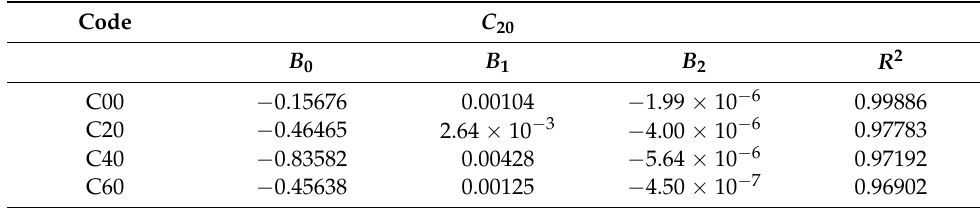
Table 5. Temperature-dependent characterization parameters of the model parameter C 20 for four types of rubbers.